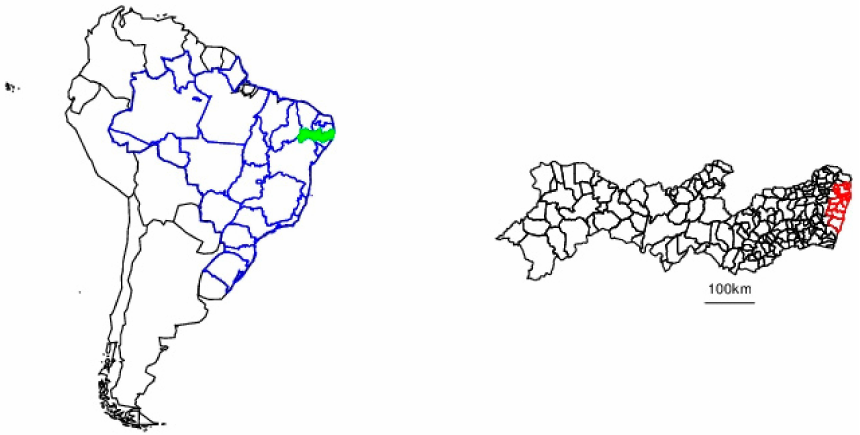
Figure 1. Pernambuco. Left panel: South America, with the national boundaries in black, and the Brazilian state boundaries in blue. Pernambuco is shown in green. Right panel: municipalities of Pernambuco, with those of the Recife Metropolitan Region being shown in